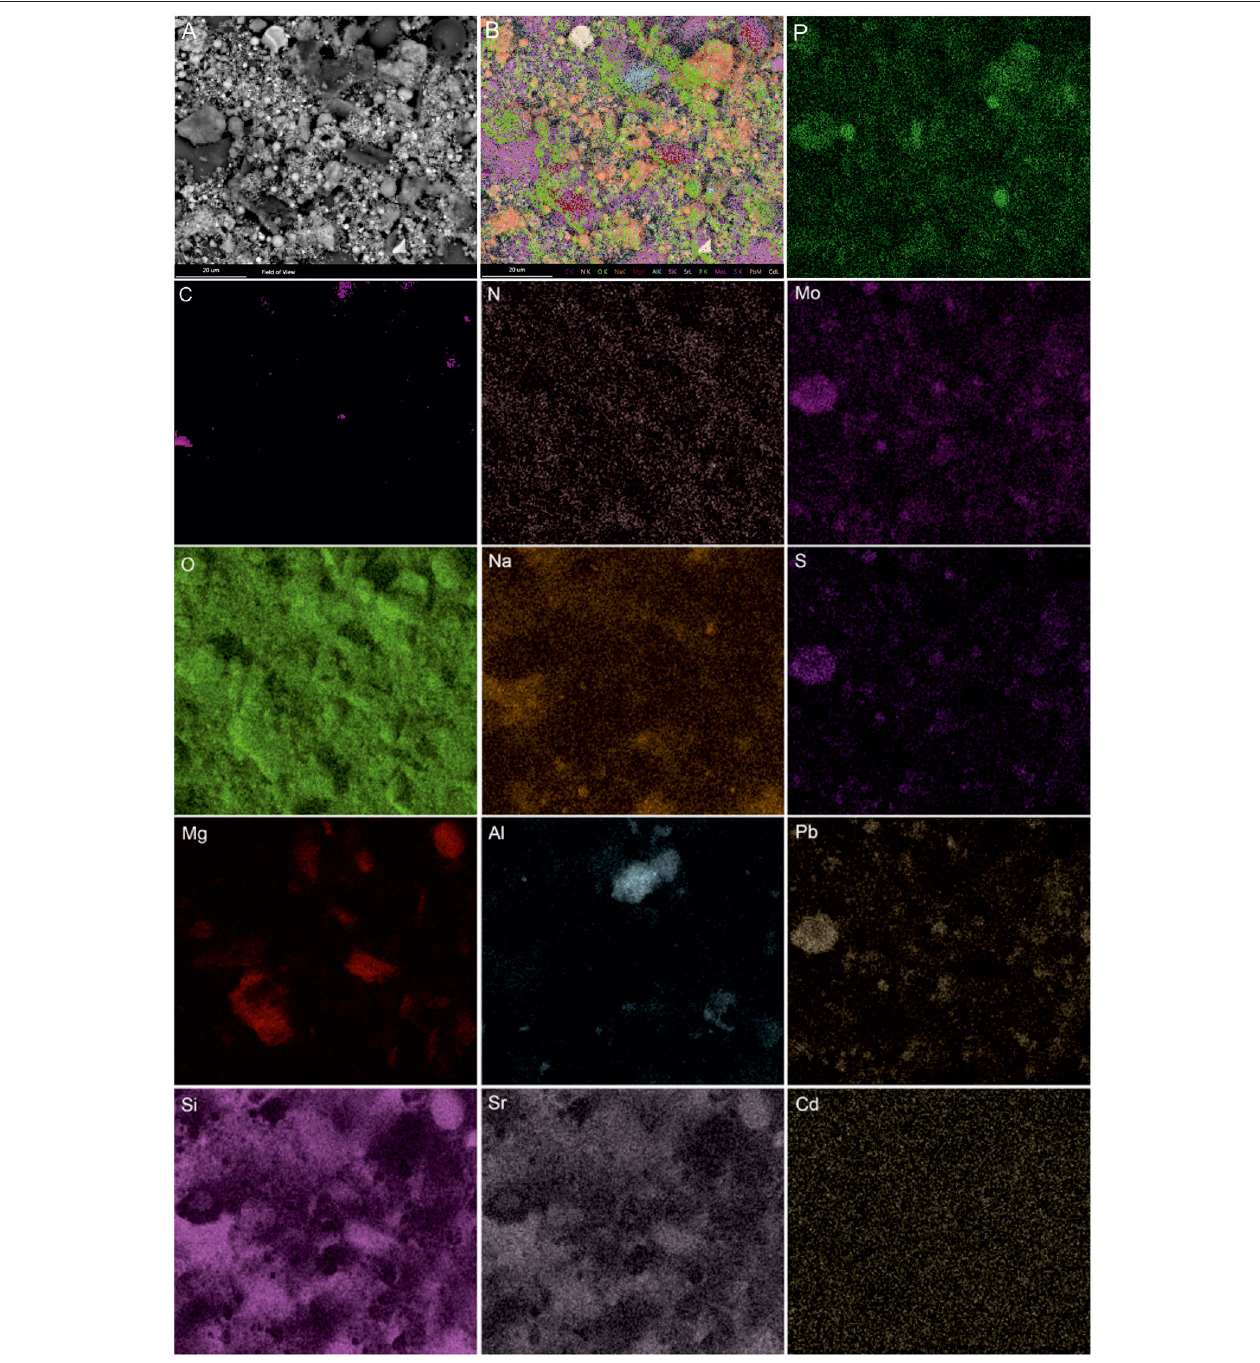
FIGURE 6 | SEM-EDS investigations of microbial-mineral assemblages formed in cultures of A. manzaensis grown on BOF-dust. Shown are the SEM image of a microbially processed sample used for the EDS spectrum image acquisition, composite image, and corresponding elemental distribution maps of phosphorus (P), carbon (C), nitrogen (N), molybdenum (Mo), oxygen (O), sodium (Na), sulfur (S), magnesium (Mg), aluminum (Al), lead (Pb), silicon (Si), strontium (Sr), and cadmium (Cd).